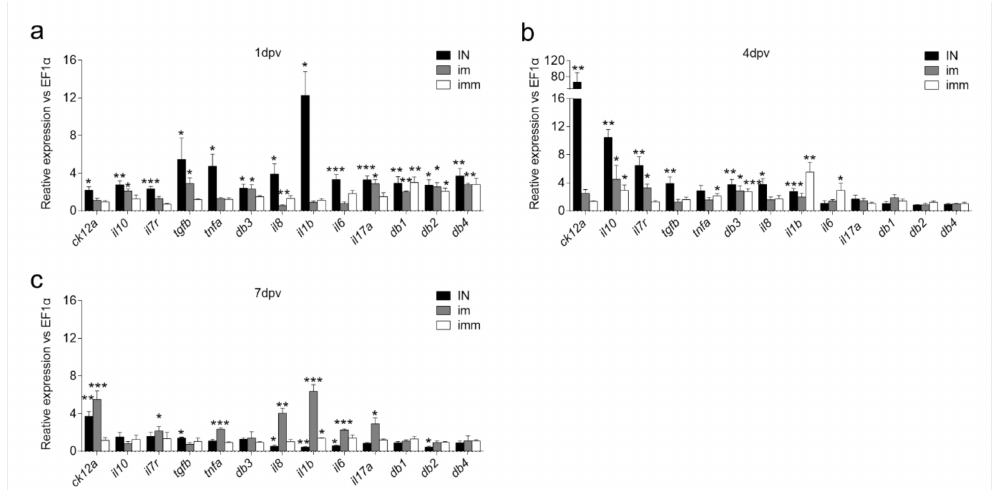
Figure 2. Kinetics of the innate immune response in trout NALT following nasal, injection or immersion vaccination with live attenuated IHNV vaccine. ( a ) Gene expression changes 1 dpv; ( b ) Gene expression changes 4 dpv; ( c ) Gene expression changes 7 dpv. Gene expression was quantified by quantitative real-time PCR ( N = 4 fish per group). Data are expressed as mean fold increase in expression ± s.e. (unpaired Student’s t -test) * P < 0.05, ** P < 0.01, *** P <